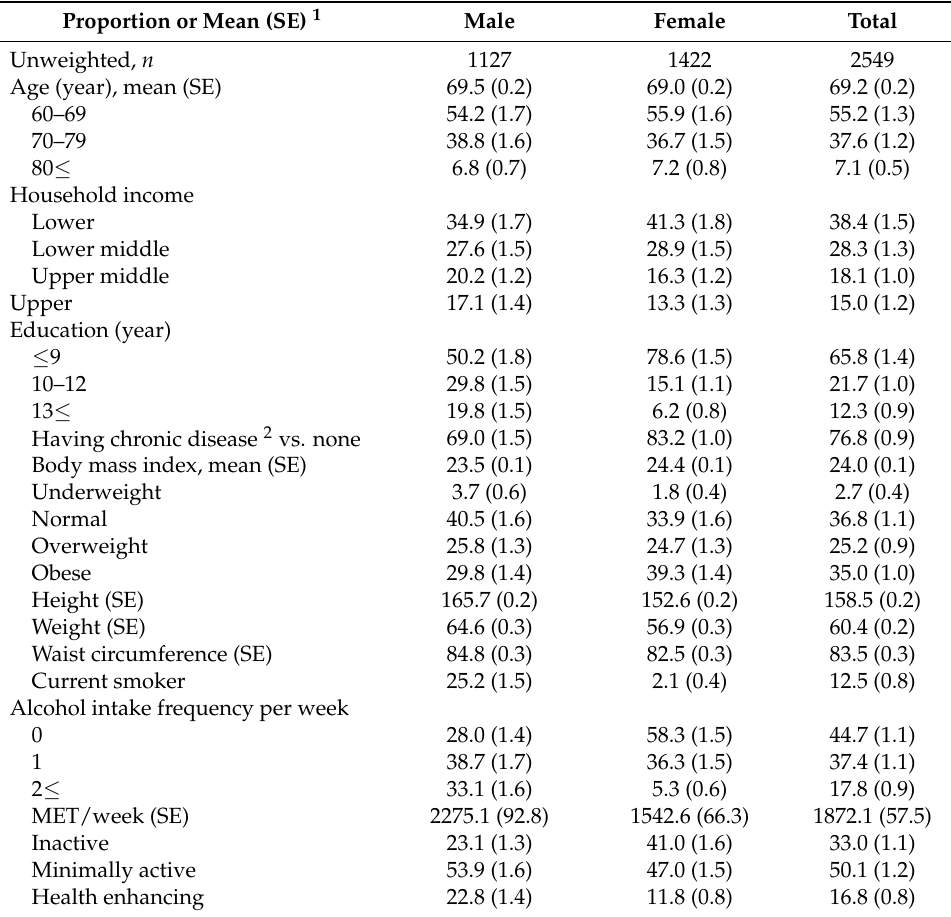
Table 1. General characteristics of the study